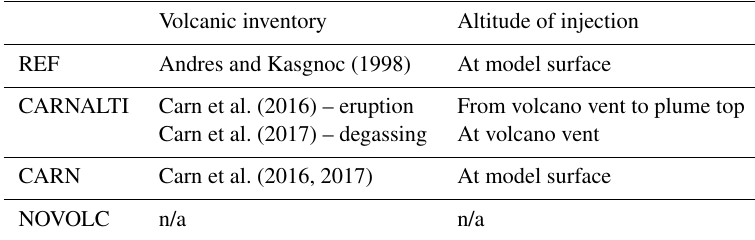
Table 2. Main features of the